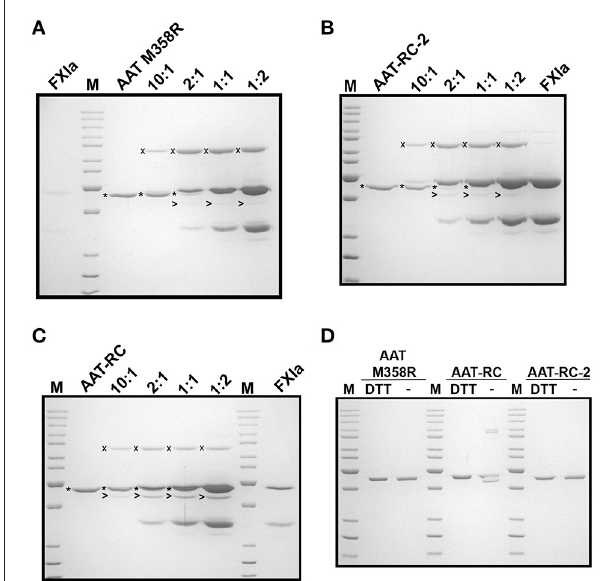
FIGURE 3 | Effects of increasing amounts of FXIa on reaction outcomes with AAT variants and electrophoretic profiles. A 10% SDS-polyacrylamide gel electrophoresed under denaturing and reducing (A–C) or reducing and non-reducing conditions (D) and stained with Coomassie Blue is shown. AAT variants (1.0 µ M) were incubated with or without 0.1–2.0 µ M FXIa, yielding molar reaction ratios of AAT/FXIa shown above the lanes. The position of AAT-FXIa serpin–enzyme complexes (x), unreacted AAT (*), and cleaved AAT ( > ) is indicated to the left of the respective bands, where reactions with AAT M358R, AAT-RC-2, and AAT-RC are shown in (A–C) , respectively. FXIa-only lanes in (A–C) correspond to 0.1, 2.0, and 0.5 µ M concentrations, respectively. (D) AAT variants identified above the lanes (0.7 µ g per lane) were electrophoresed under reducing conditions (with dithiothreitol, DTT)